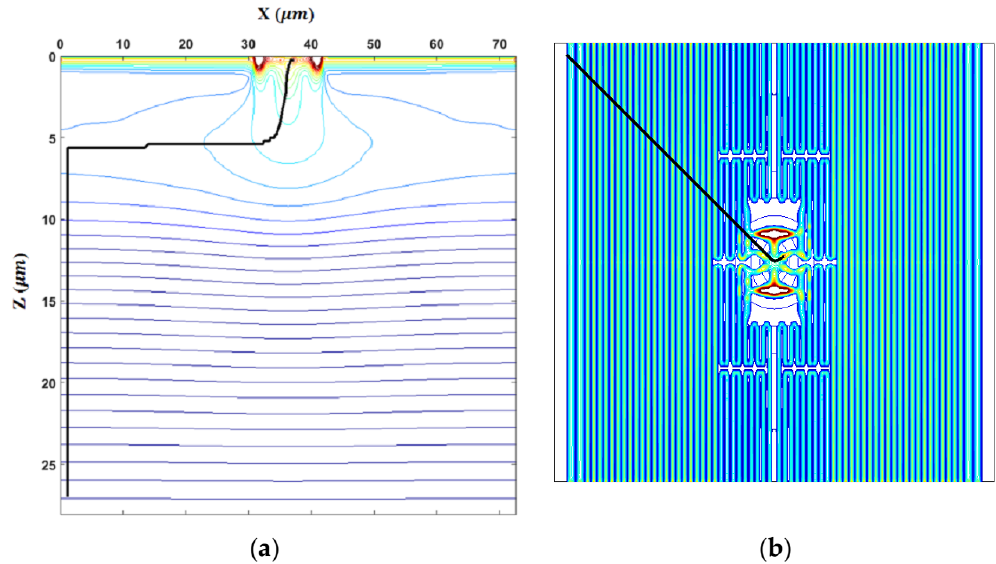
Figure 5. A cross-section of the potential profile created by the p-well and a trajectory of an electron without the random motion: ( a ) cross section; ( b ) on the x – y plane (bends are simplified, except in the central area, to avoid excessive calculation